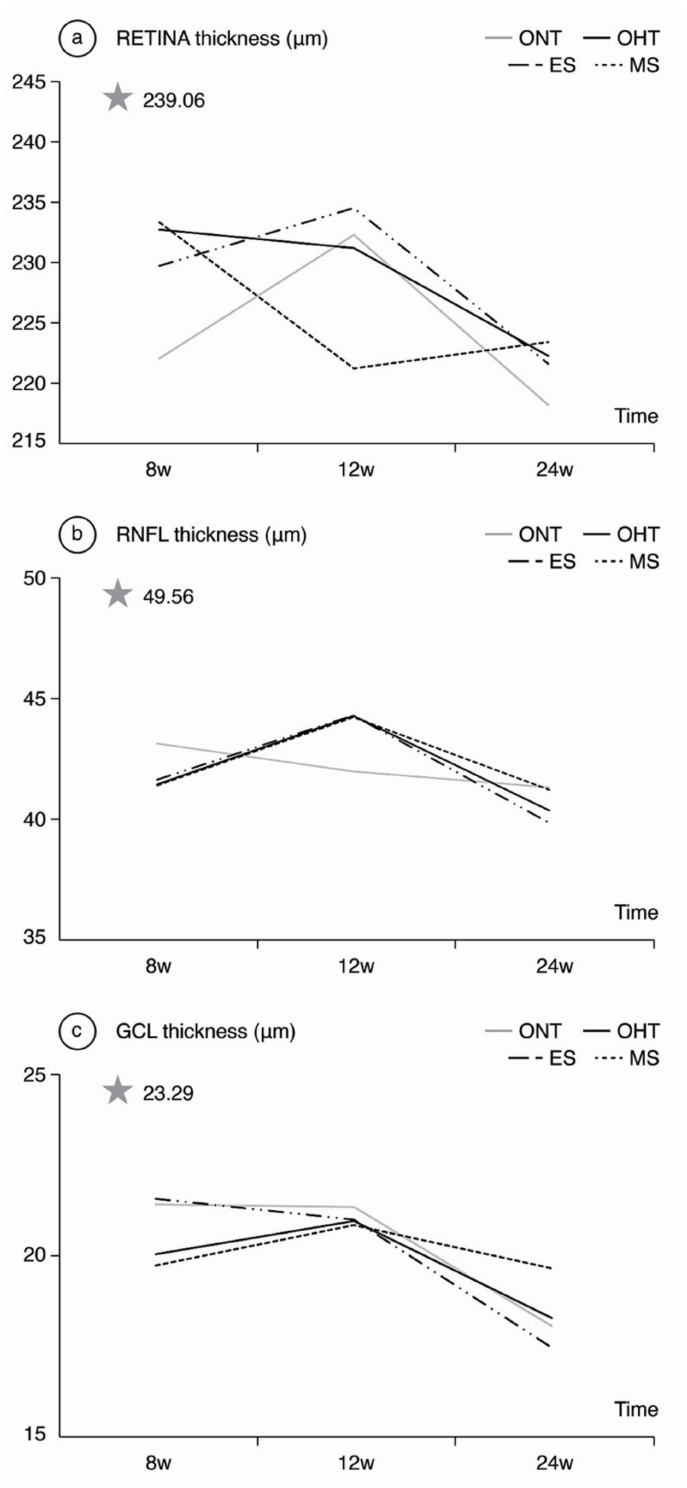
Figure 3. Neuroretinal thickness measured by optical coherence tomography in both the ocular normotension and ocular hypertension cohorts and the ocular hypertension sub-groups at 8, 12, 24 weeks follow-up. ( a ) Retina thickness, ( b ) Retina nerve fiber layer thickness, ( c ) Ganglion cell layer thickness. The analysis is based on the mean values of all the OCT sectors. ONT: ocular normotension cohort; OHT: ocular hypertension cohort; ES: episcleral sclerosis group; MS: microspheres group; RNFL: retinal nerve fiber layer; GCL: ganglion cell layer; µ m: thickness in micrometers; W: week; star: baseline